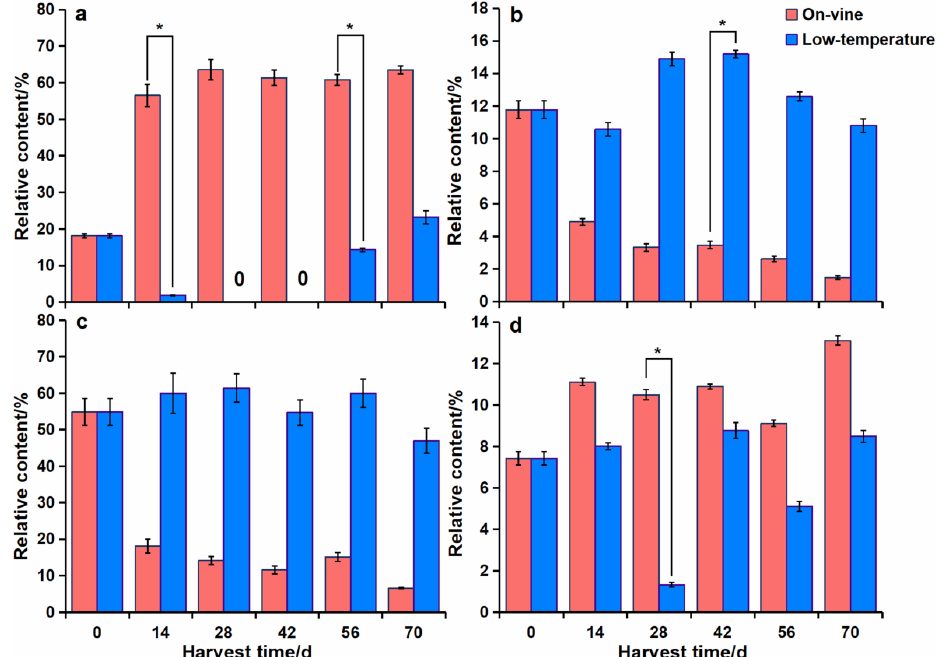
Figure 8. Changes of main aroma components of kiwifruit under the two softening modes. ( a ) 2- carene. ( b ) Hexanal. ( c ) 2-hexenal. ( d ) d-limonene. Error bars represented standard deviations of means. ‘*’ represented significant difference at p < 0.05. Table 2. The aroma substances of evident characteristics.